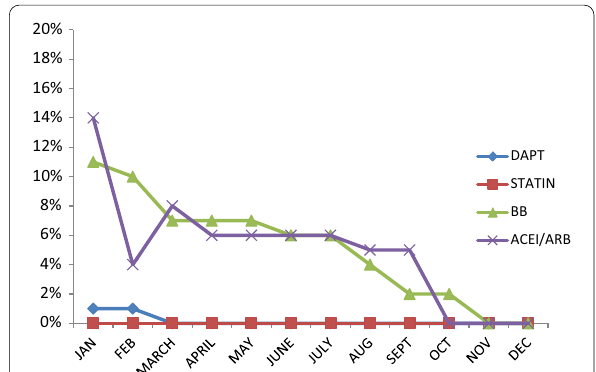
Fig. 1 Unreasonable omission of evidence-based medications over 12 months. ACEI angiotensin-converting enzyme inhibitor, ARB angiotensin receptor blocker, B beta-blockers